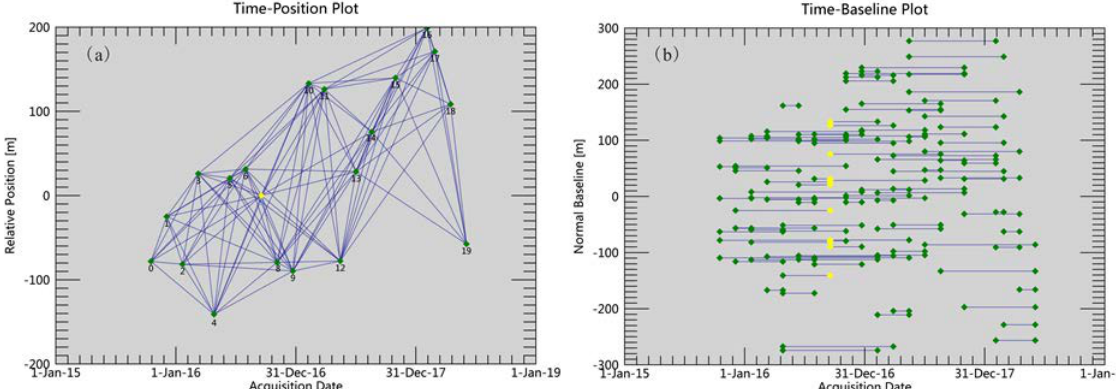
Figure 3. ( a ) Time–position of Radarsat-2 image interferometric pairs and ( b ) time–baseline of Radarsat-2 image interferometric pairs. The yellow diamond denotes the super master image. Blue lines represent interferometric pairs. Green diamonds denote slave images.